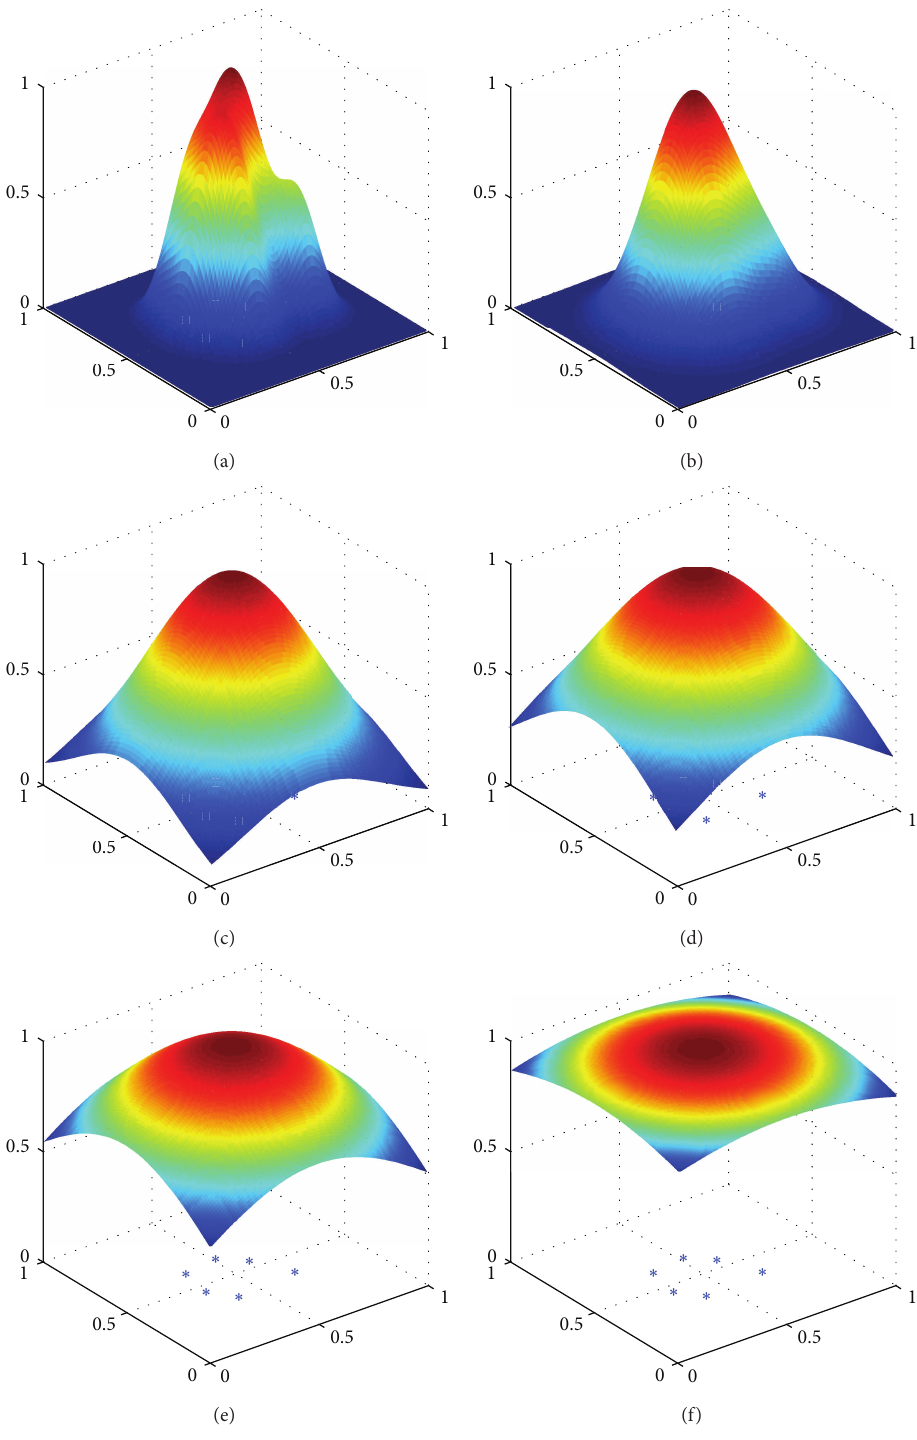
Figure 4: 2D Gaussian MFs with different values of 𝛾 : (a) 𝛾 = 15 ; (b) 𝛾 = 10 ; (c) 𝛾 = 4 ; (d) 𝛾 = 3 ; (e) 𝛾 = 2 ; (f) 𝛾 = 1 . The patterns determining the convex hull are plotted as asterisks in the data